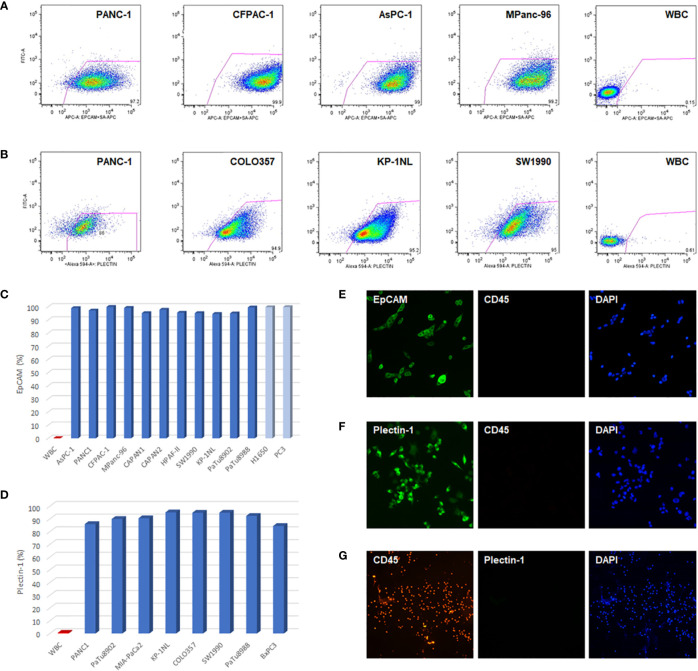
EpCAM and Plectin-1 expression in PDAC cells. To evaluate the anti-EpCAM and anti-Plectin-1 antibodies for detecting CTCs, the expression of EpCAM and Plectin-1 antigen was examined in PDAC cell lines by flow cytometry. (A) The surface expression of EpCAM in PDAC cell lines (PANC-1, CFPAC-1, AsPC-1, MPanc-96). (B) The expression of Plectin-1 in PDAC cell lines (PANC-1, COLO357, KP-1NL, SW1990). The expression of (C) EpCAM and (D) Plectin-1 in various PDAC cell lines were represented as percentages. WBCs were used as negative controls. To examine the expression of EpCAM and Plectin-1, (E) CAPAN-1 cells were stained with EpCAM (green) and CD45 (red), (F) MIA-PaCa2 cells were stained with Plectin-1 (green) and CD45 (red), and (G) WBCs were stained with CD45 (red) and Plectin-1 (green). All nucleated cells were stained with DAPI (blue).